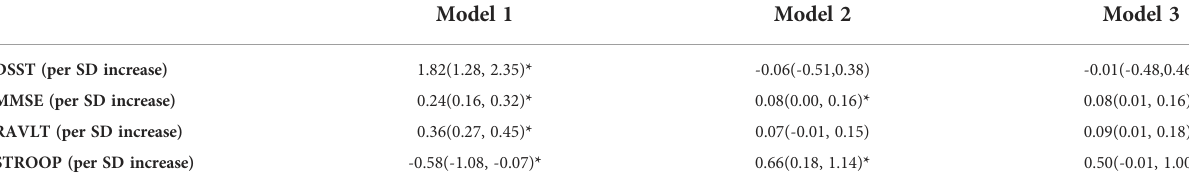
TABLE 2 Association between BMI and cognitive test results at baseline and during the follow-up period, adjusted for potential confounders.